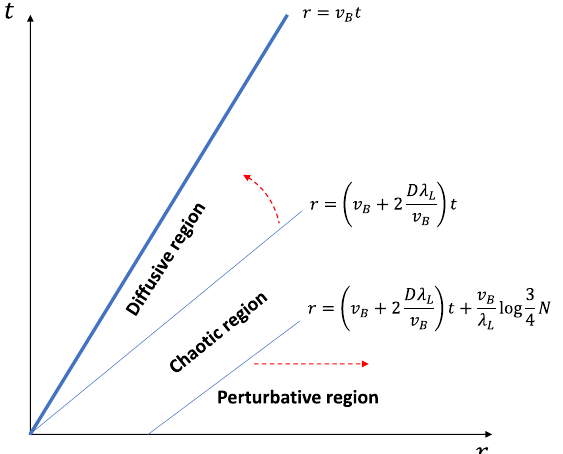
FIG. 2. The scrambling “ phase diagram ” in space-time. An overall unimportant spatial offset is omitted. The bold line marks the wave front. The space-time is roughly divided into three regions. In the diffusive region, the squared commutator exhibits a diffusively broadening wave front, quantitatively different from the exponential growth in the large- N limit. Away from the wave front, there is a region where the squared commutator grows exponentially with a modified Lyapunov exponent. Further ahead of the wave front, the chaotic region gives way to the perturbative region. As N increases, the chaotic region expands as indicated by dashed arrows, and it eventually dominates the wave-front behavior in the infinite- N